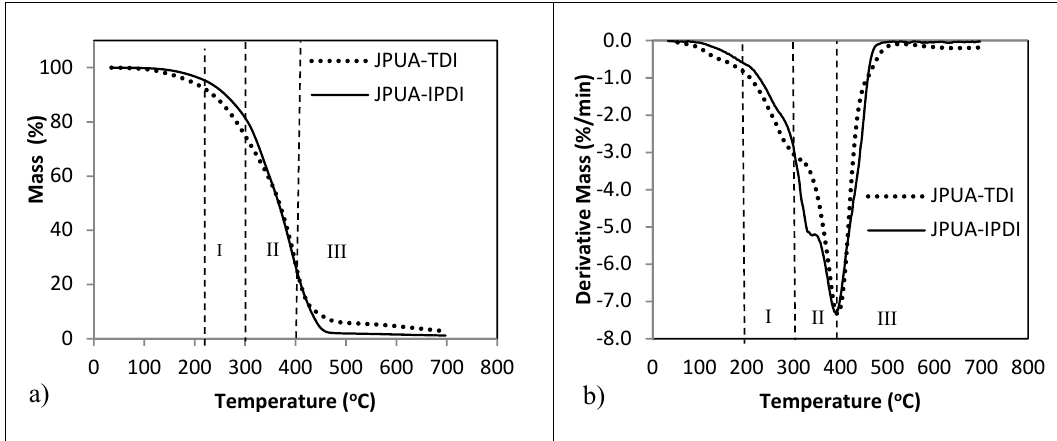
Figure 5. ( a ) Thermal gravimetric analysis (TGA) thermogram and ( b ) derivative curve of JPUA-TDI and JPUA-IPDI.